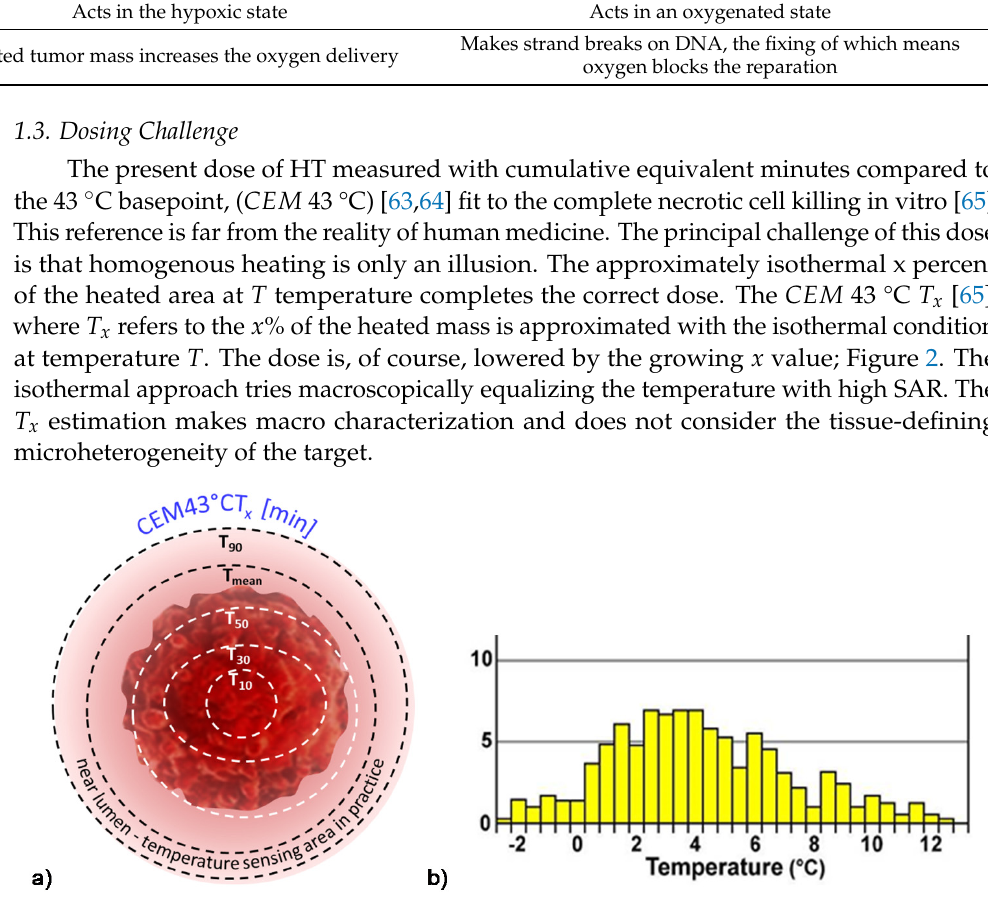
Figure 2. The heated focus rapidly spreads, so the temperature increases in a broader region. ( a ) The CEM43 dose depends on the isothermal areas, which differ by distance and develop by time. ( b ) The temperature distribution across the tumor after 64 min of treatment was measured by MRI (Pat.10. relapsed rectum carcinoma) [66].